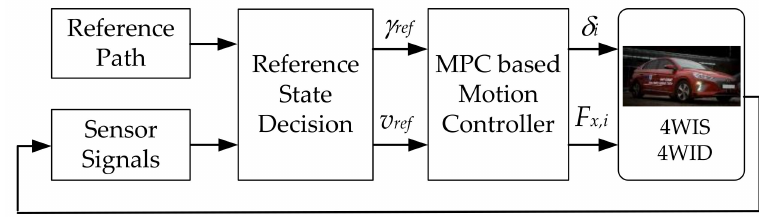
Figure 1. Schematic diagram of the proposed